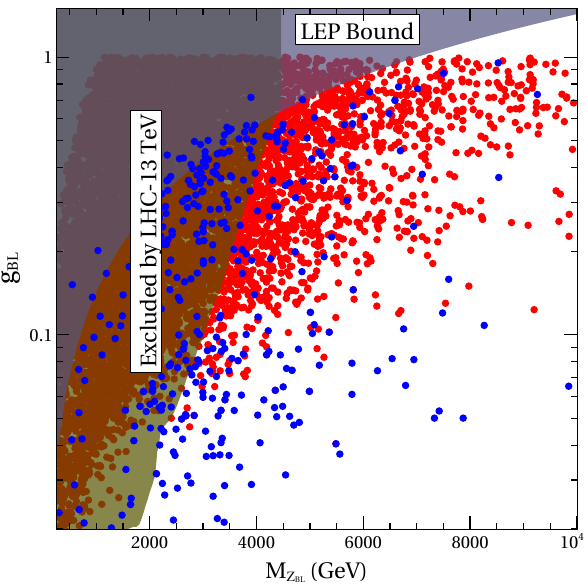
Figure 10 . Summary plot showing the allowed points with and without applying the direct detec- tion bounds from XENON1T